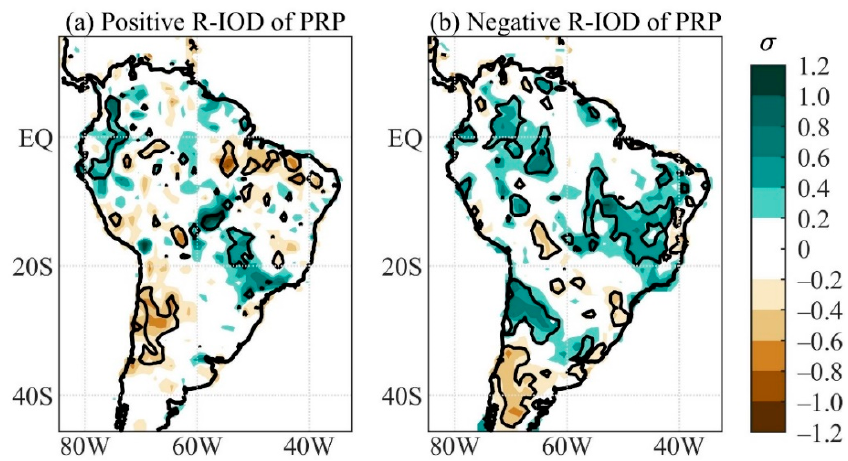
Figure 11. Composites of the residual precipitation anomalies during austral spring for the: ( a ) positive R-IOD; ( b ) negative R-IOD. In this Figure, residual means without the TPO effects. Graphical display is the same as that in Figure 6.